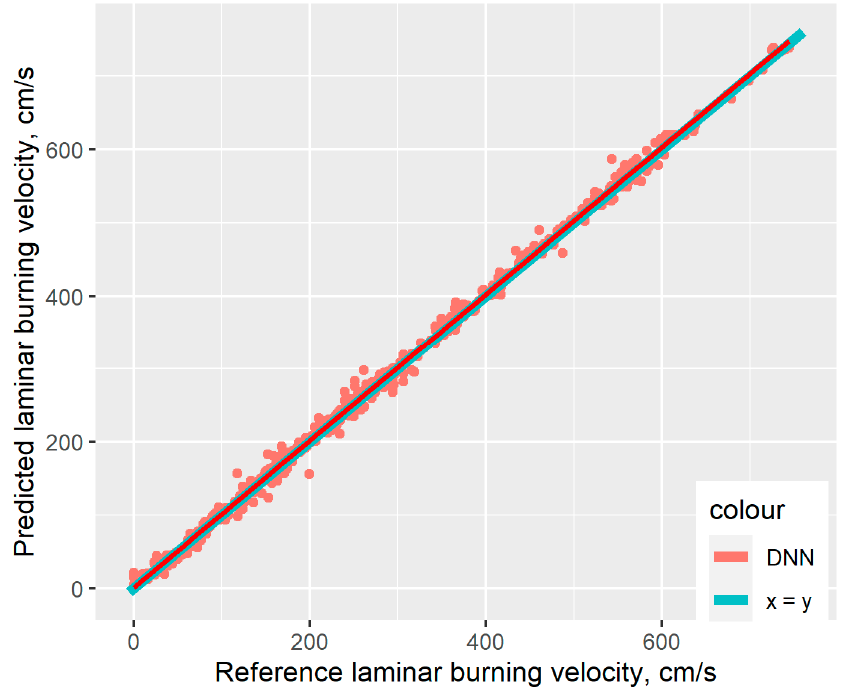
Figure 5. DNN predictions versus experimental data.